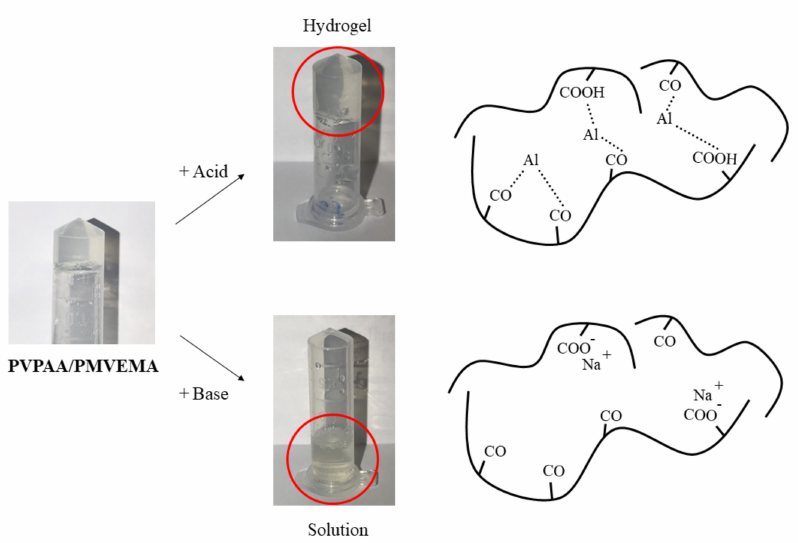
Figure 5. The appearance of the PVPAA/ PMVEMA in acidic and basic